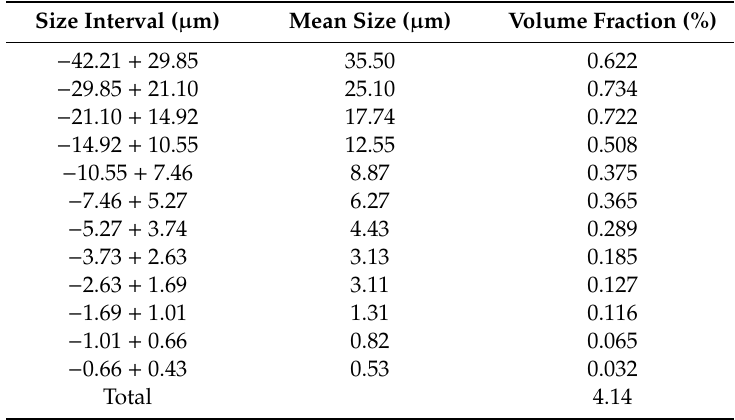
Table 1. Size distribution and respective volume fraction of particles in the feed.